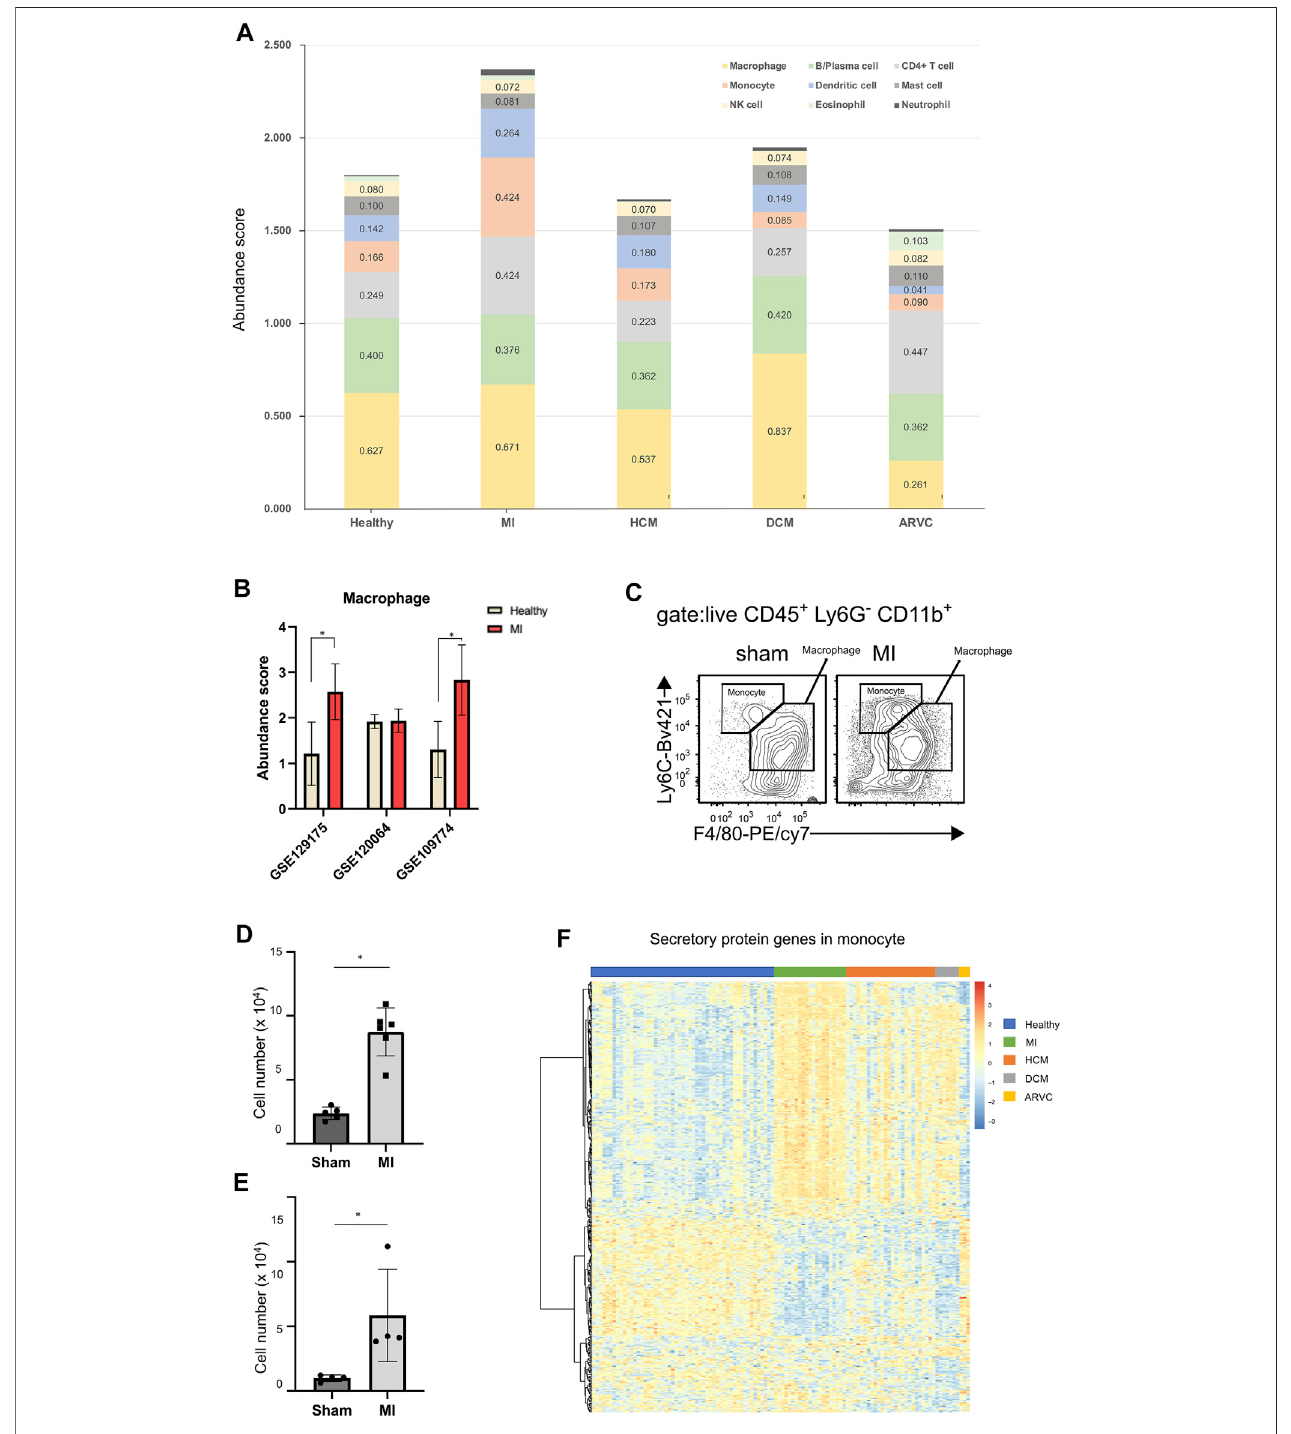
FIGURE6 | Immunecell in fi ltrationanalysisof reconstructed heart transcriptomes acrossvariouscardiac disease conditions. (A) Bar plots showing thevariation in the proportions of the 22 immune cell subtypes (LM22 reference) across different cardiac diseases. Each color represents a speci fi c immune cell subtype. (B) Comparison of macrophage abundances estimated by using the alternative scRNA-seq references. (C) Flow cytometry assay verifying that macrophages and monocytes are increased in mouse heart tissues of myocardial infarction (MI) at the 1st week after model preparation. The result shows a representative sample of fl ow cytometry. Gating strategy for macrophage: CD45.2 + Ly6G − CD11b + F4/80 + ; gating strategy for monocyte: CD45.2 + Ly6G − CD11b + F4/80 − . (D) Statistical chart ( n =5, p =2.368×10 – 3 ,Student ’ s t -test)showingthemacrophageincreasinginMI. (E) Statisticalchart( n =4, p =3.598×10 – 2 ,Student ’ s t -test)showingthemonocyte increasing in MI. (F) Heat map showing the expression pattern of secretory protein genes in monocytes across different disease conditions.